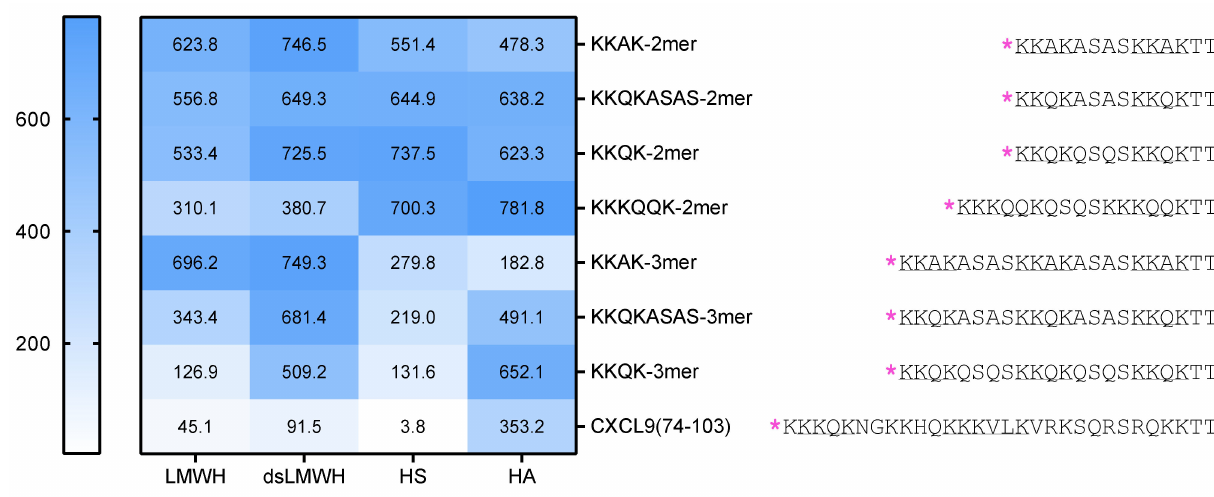
Figure 5. Overview of the K d values obtained from the IFT experiments. The K d values of the interactions of the different peptides with (ds)LMWH, HS and HA are displayed in nM. The amino acid sequences of the peptides are depicted on the right with TAMRA indicated in pink [*] and the GAG-binding motifs